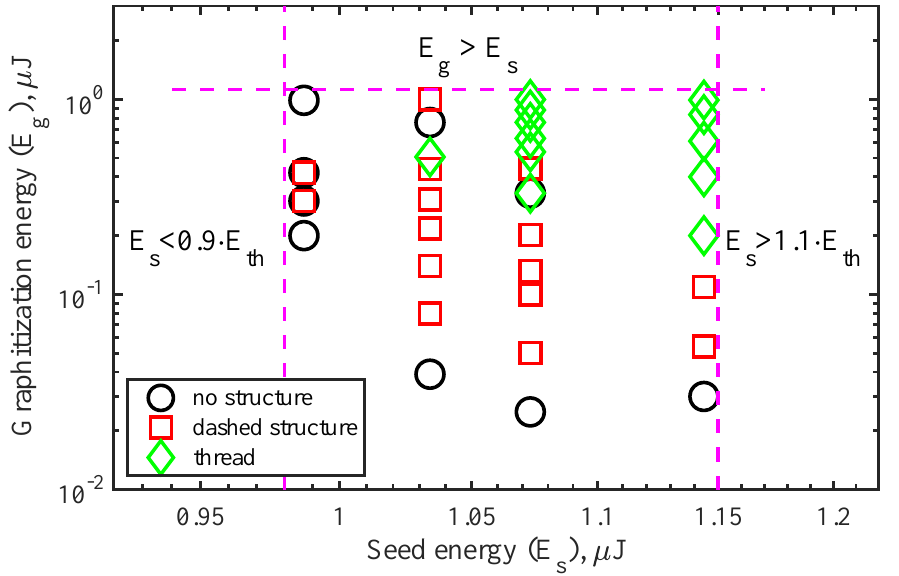
Figure 6. Map of formation of graphitized wires produced in diamond at a given seed energy and a given graphitization energy. The magenta lines depict the energy variation ranges—see details in the